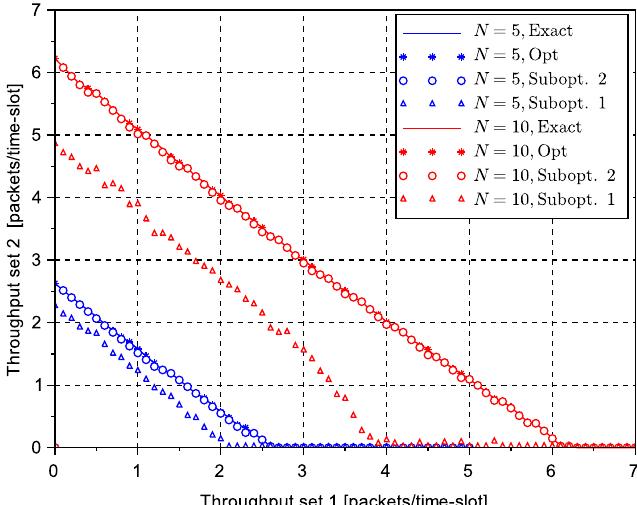
Figure 4. Throughput region of a multi-packet reception (MPR) system with two subsets of terminals: J 1 = 30 and J 2 = 30 using the N -reception model with different values of N